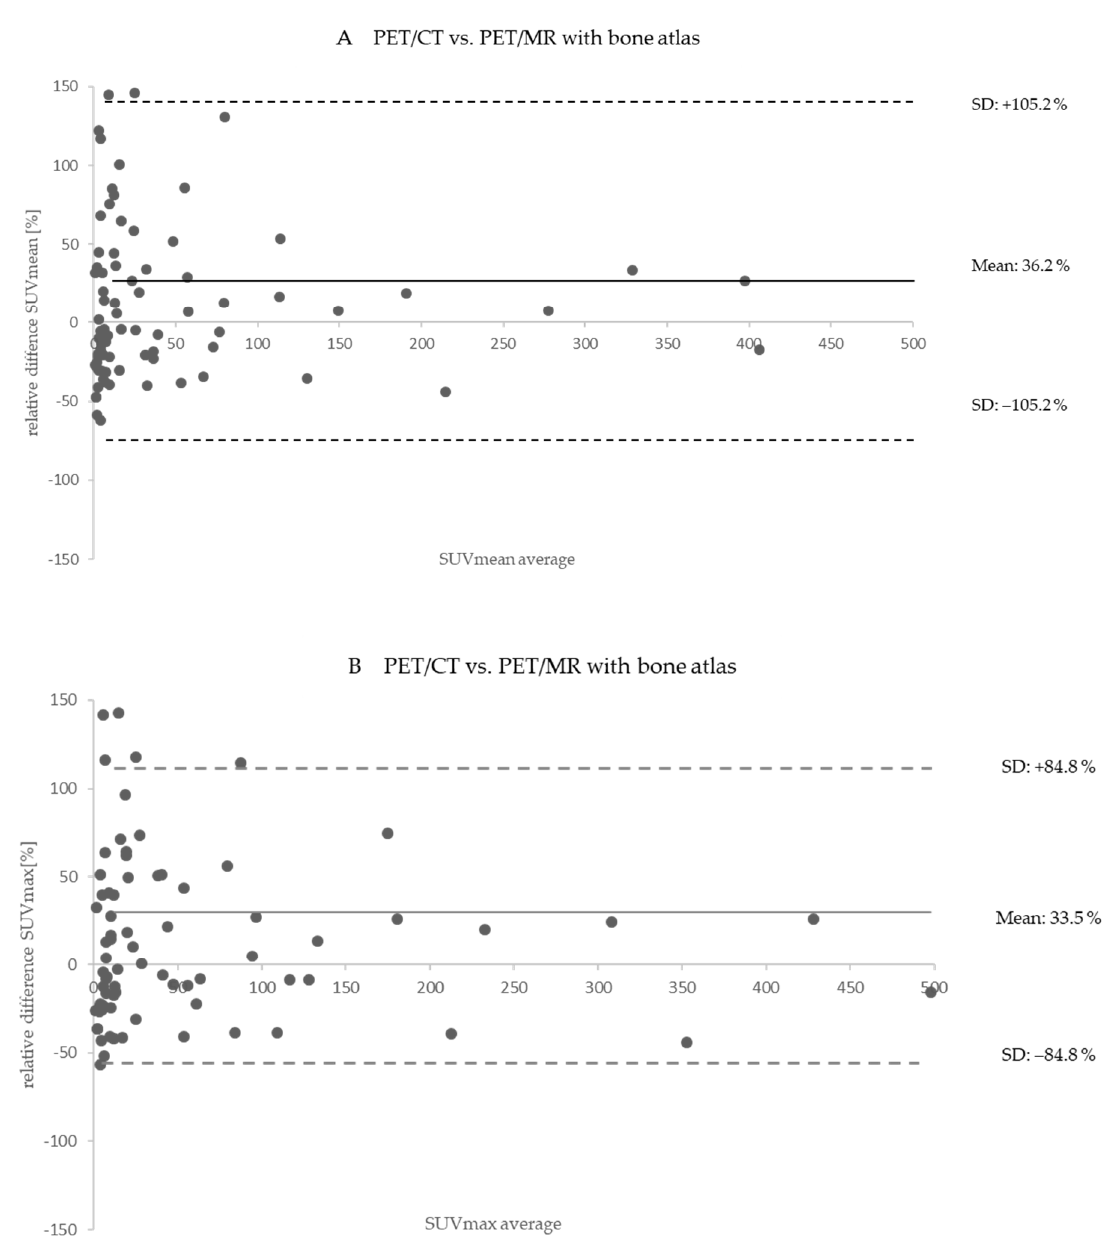
Figure 5. ( A ) Bland − Altman plot shows the relative quantitative differences in SUVmean for 98 congruent iodine − positive lesions measured in PET/CT (reference) vs. PET/MR corrected with MR − based AC with bone atlas. Note that PET/MR resulted in overall higher lesion SUV max than the PET/CT measurements. ( B ) Bland–Altman plot shows the relative quantitative differences in SUV max for 98 congruent iodine-positive lesions measured in PET/CT (reference) vs. PET/MR corrected with MR-based AC with bone atlas. Note that PET/MR resulted in overall higher lesion SUV max than the PET/CT